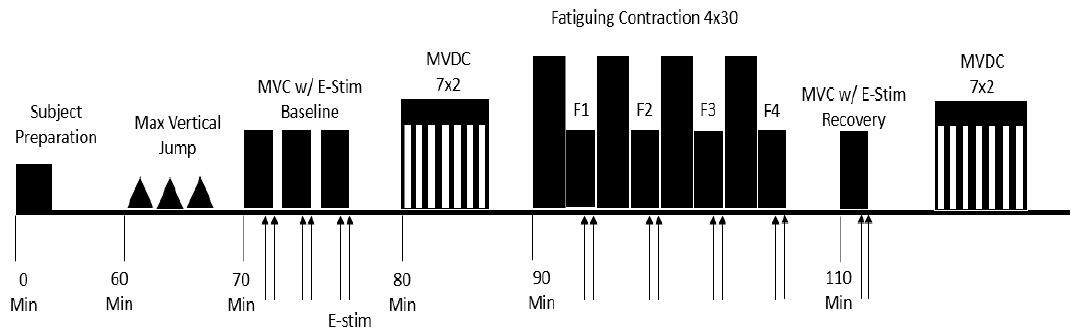
Figure 1. Experimental protocol for both control and supplemental sessions. Upward arrows denote electrical stimulation during maximum voluntary isometric contractions (MVIC) and rest. Hatched bars denote maximal voluntary concentric contractions (30 reps) with a load equivalent to 20% MVIC.